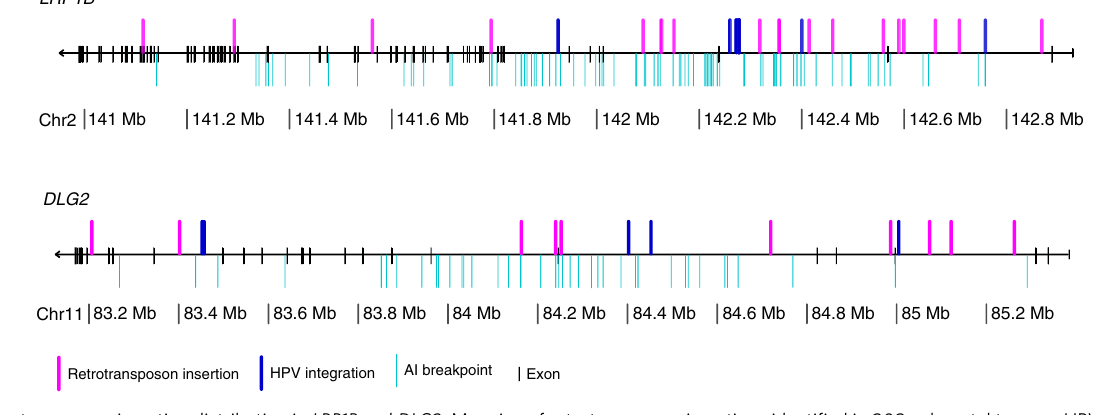
Fig. 3 Retrotransposon insertion distribution in LRP1B and DLG2 . Mapping of retrotransposon insertions identi fi ed in 202 colorectal tumors, HPV integration hotspots reported in 135 cervical cancers and allelic imbalance breakpoints identi fi ed in 1,699 CRCs 31,36 . Figure plotted with genoPlotR 64 . Source data are provided as a Source Data fi le